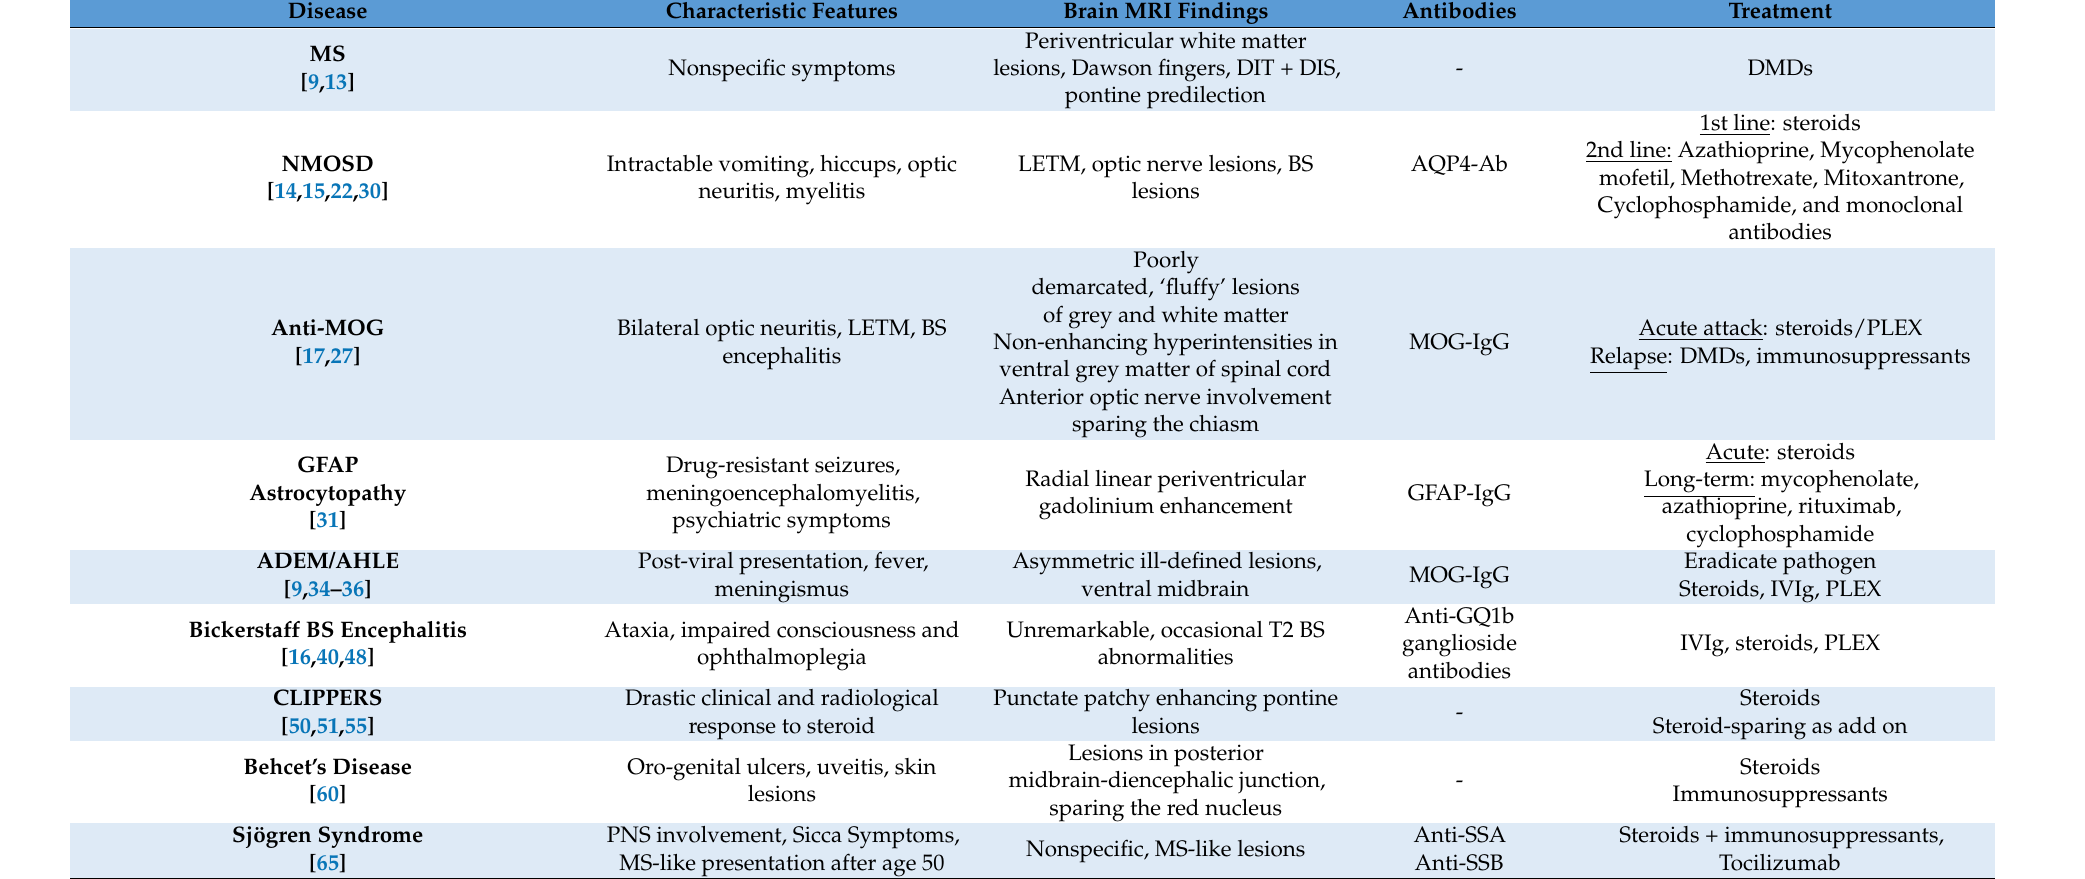
Table A1. Summary of Inflammatory Brainstem Diseases with Clinical Features, Imaging, Antibodies, and